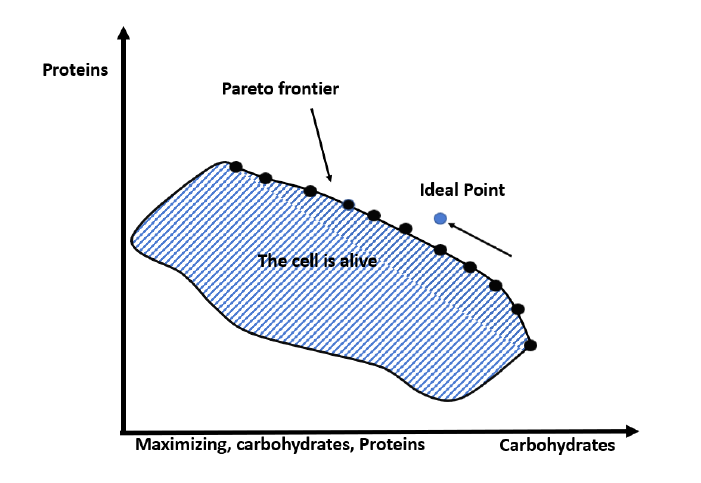
Figure 1. Two-objective Pareto